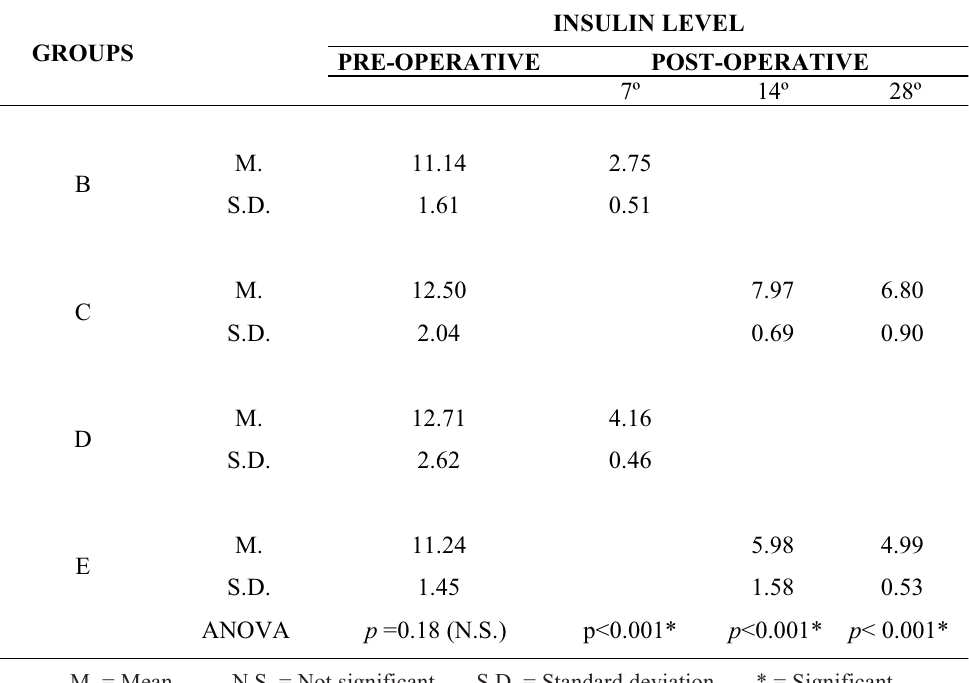
TABLE 3 - Means (µU/mL) and respective standard deviations of the peripheral blood insulin levels pre-operative and post-operative in the animals of groups B (apancreatic), C (autotransplant), D